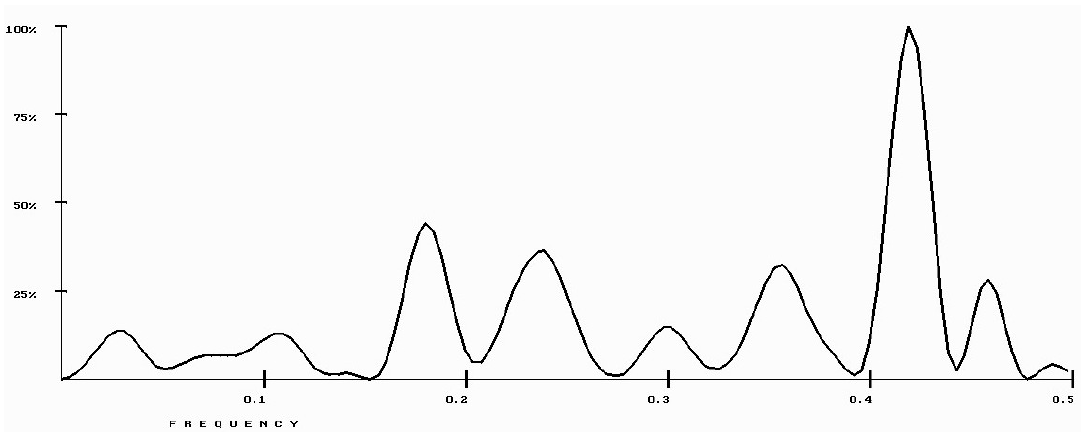
Figure 3. RRM cross-spectrum of parathyroid hormone protein fragment 1-34.